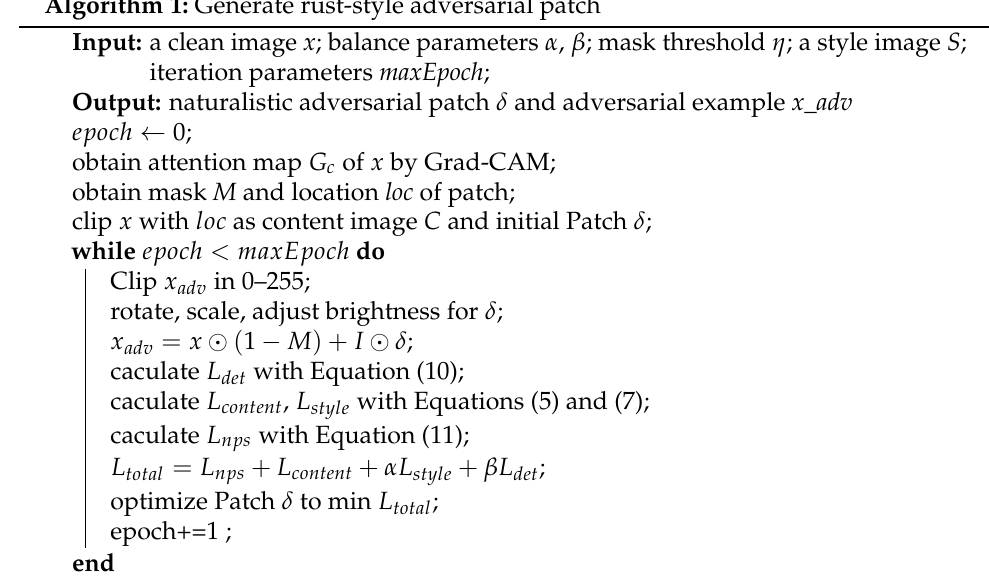
Algorithm 1: Generate rust-style adversarial